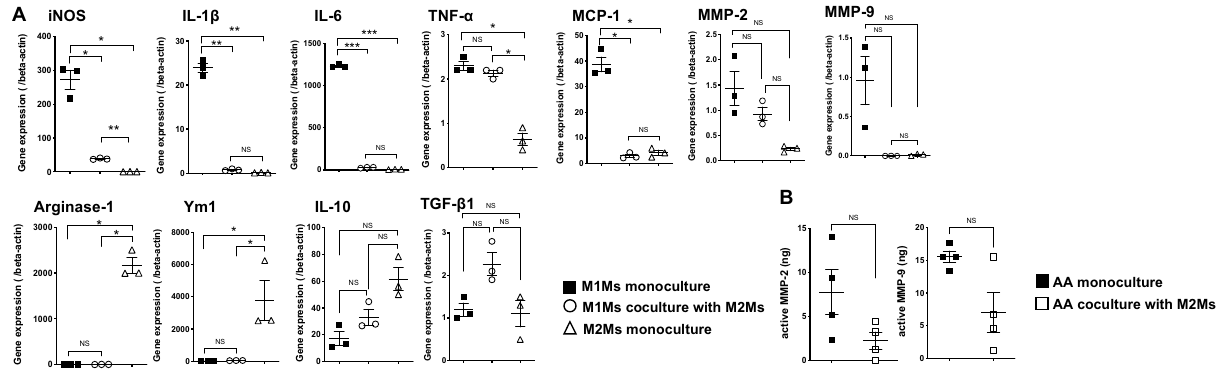
Figure 6. Gene expression levels in M1Ms and M2Ms, and MMP enzymatic activity levels in AA tissues. ( A ) Gene expression measured by quantitative RT-PCR. Data are means ± SEM. * p < 0.05, ** p < 0.01, and *** p < 0.001 assessed by Dunnet’s T3 multiple comparisons test. ( B ) MMP-2 and MMP-9 enzymatic activity. Data are means ± SEM. M1M: M1 macrophage, M2M: M2 macrophages, AA: aortic aneurysm. NS: not